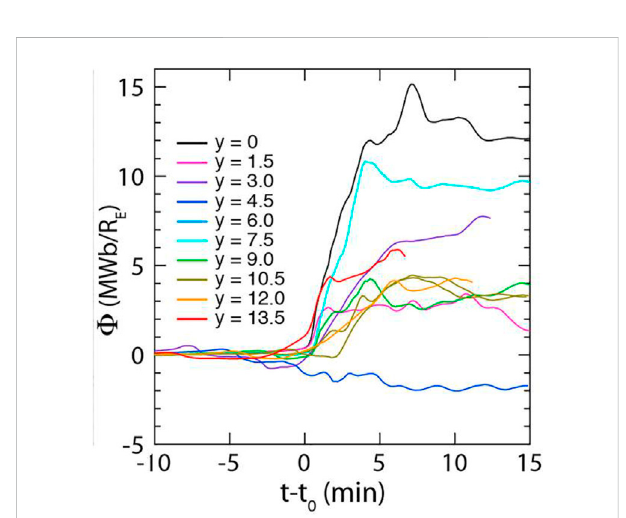
FIGURE 2 From Birn etal., 2019. Evolution ofmagnetic fl ux ( Φ )values in the simulation for 10 evenly spaced Y GSM values (indicated by different colors) at x = − 13.5R E , relative to the onset of dipolarization (t-t0 =